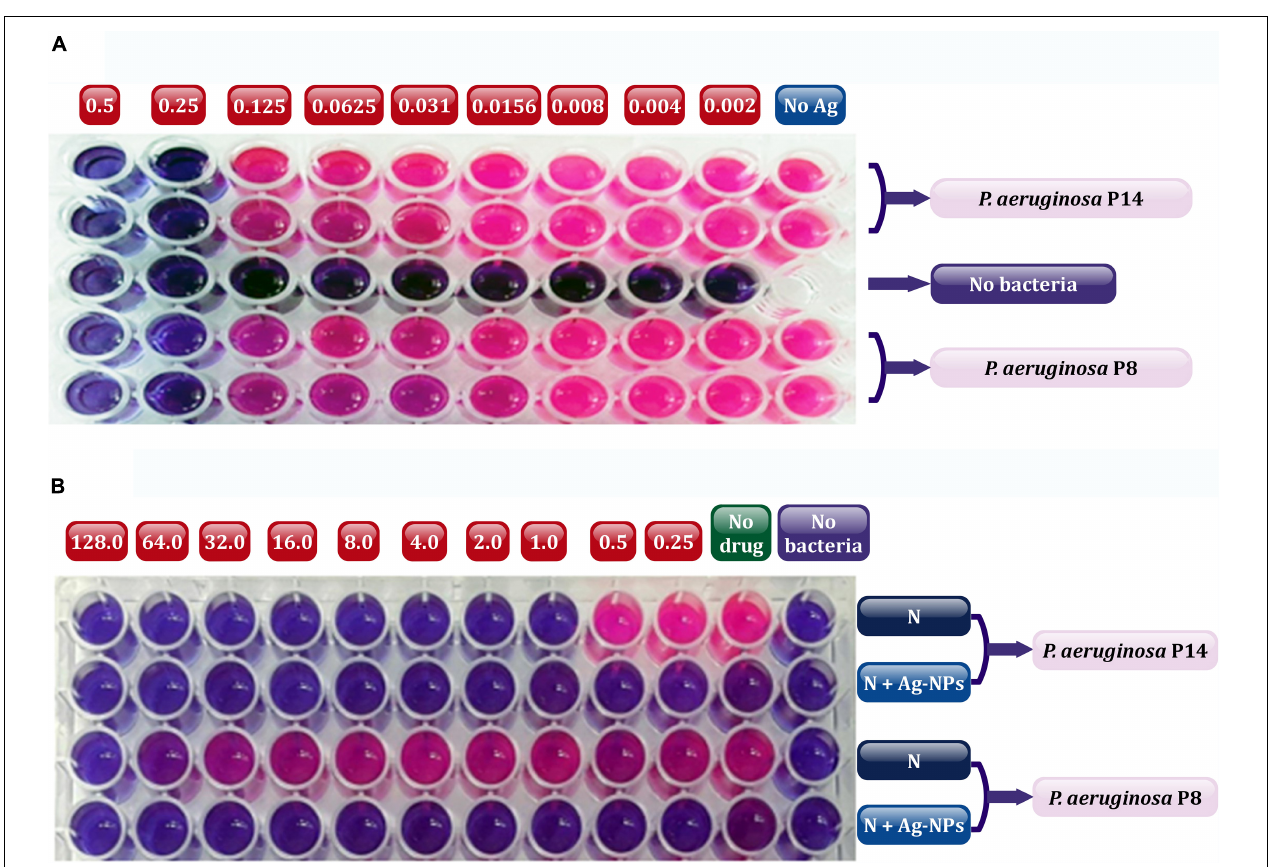
FIGURE 6 | Determination of MIC values using resazurin microtiter plates showing Ag-NPs (A) , and neomycin alone or in combination with Ag-NPs (B) against selected P8, and P14 isolates. In the plate (A) , the numbers above the plate indicate the concentration of Ag-NPs ( µ g/ml) applied to each wells column; no Ag, without addition of Ag-NPs (positive control). In panel (B), the numbers above the plate indicate the concentration of neomycin ( µ g/ml) added to each column of wells; no drug, without addition of neomycin (positive control); no bacteria, without bacterial addition (negative control). N, neomycin; Ag-NPs, silver nanoparticles. The red color indicated actively metabolizing cells and dark blue color indicated the complete inhibition of bacterial growth in the wells of microtiter